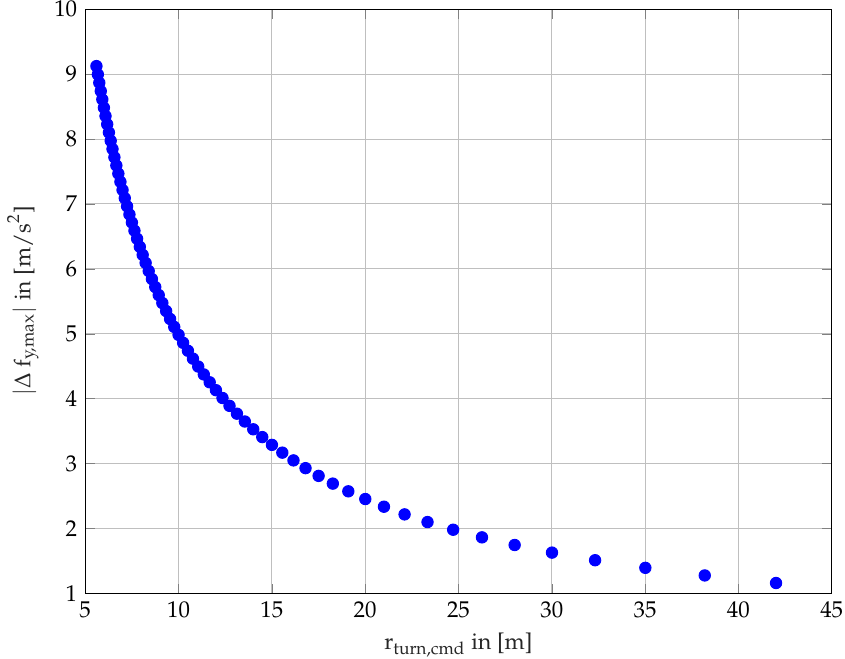
Figure 2. Maximal absolute lateral deviation over turn radius for 180°-turn maneuver.